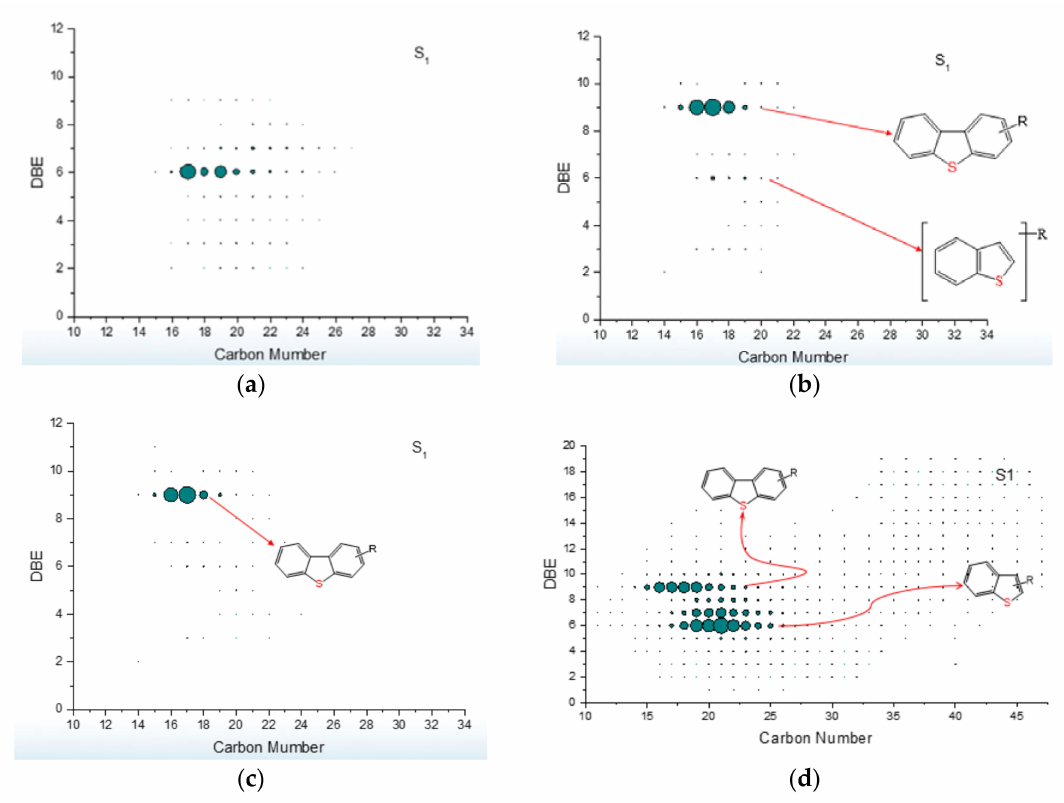
Figure 3. The FT-ICR MS distribution spectra of thiophene sulfur: ( a ) WLT, ( b ) HCT, ( c ) QZT, and ( d )